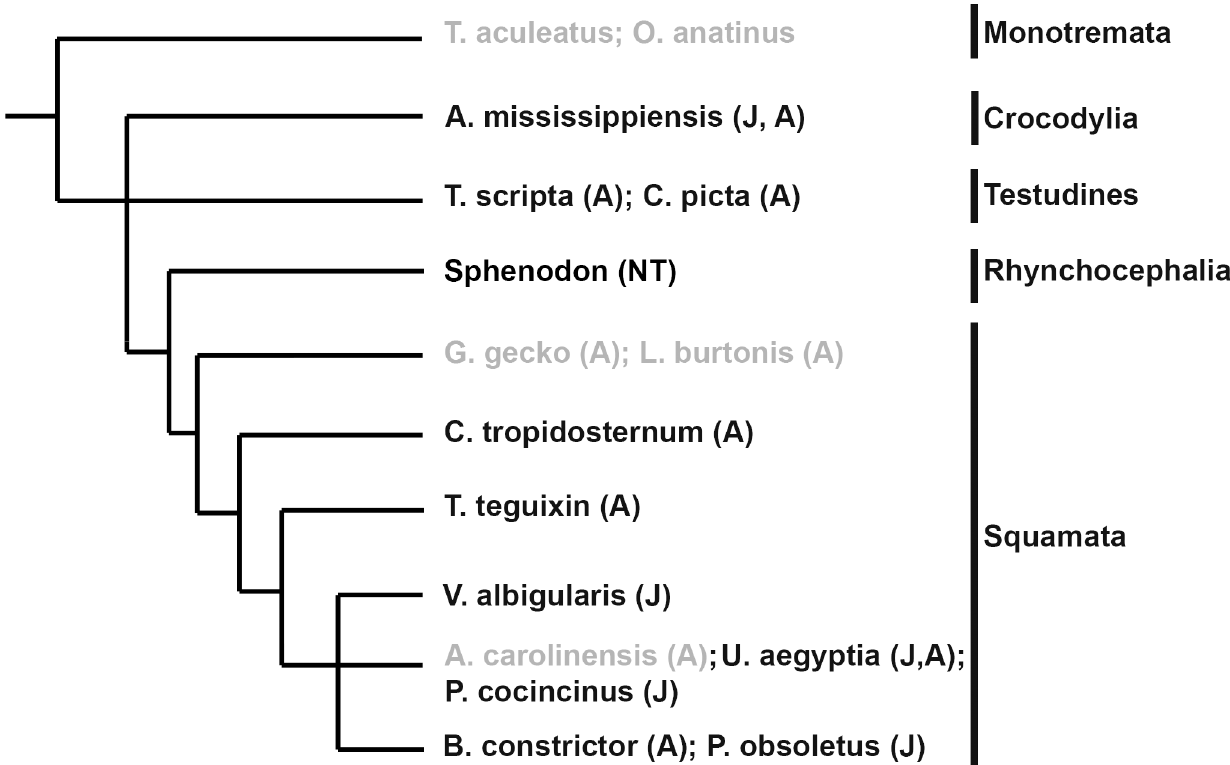
Fig 3. Species surveyed for post-embryonic nephrogenesis. Cladogram displaying species tested for presence of nephrogenesis in juvenile (J) or adult (A) kidney. Two species of monotremes, Tachyglossus aculeatus (short-beaked echidna) and Ornithorhynchus anatinus (platypus), were used for comparison as the most basal mammalian group. As with other mammals, no evidence of nephrogenesis was detected in the monotreme species. Post-embryonic nephrogenesis was detected in all major reptilian groups surveyed. Species names in light gray did not display evidence of nephrogenesis. NT = not